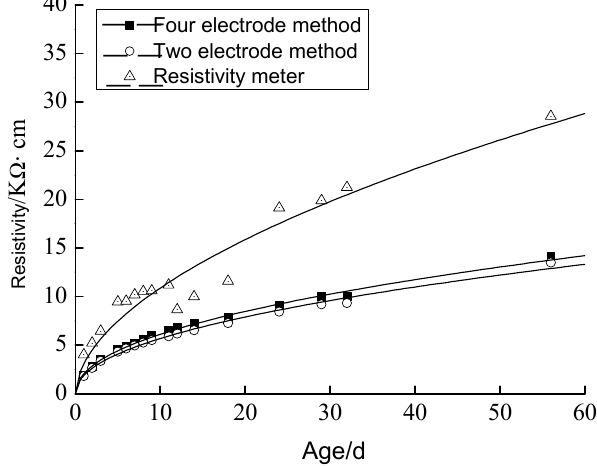
Figure 14. The mean and variance of the resistivity of the CMA_D groups.